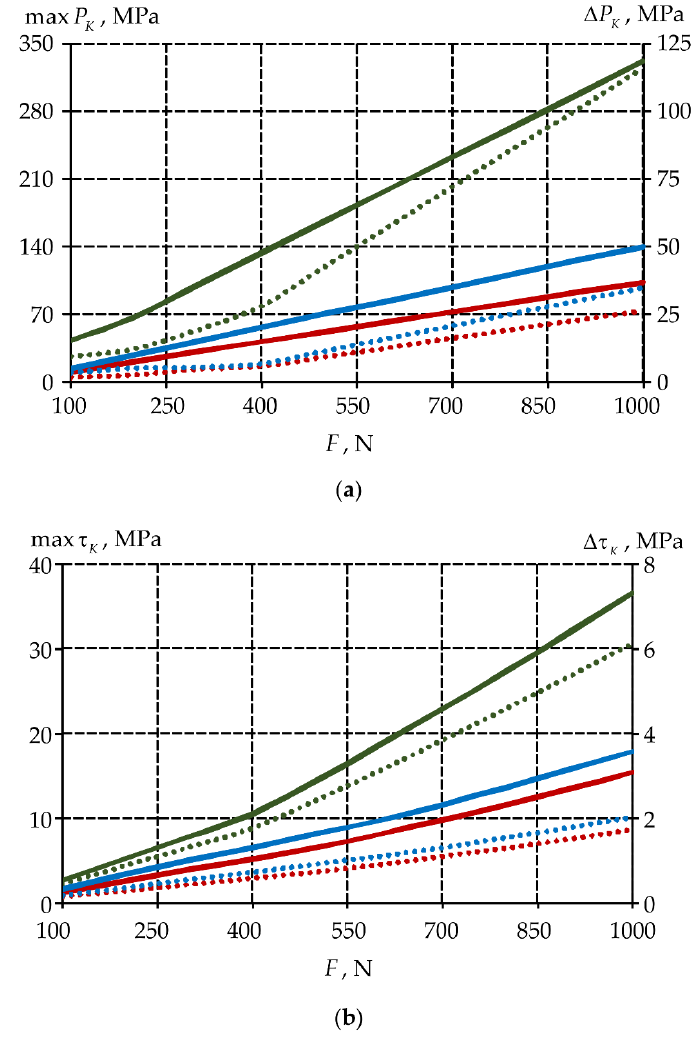
Figure 11. Dependence of contact parameters in the inlay on the load: ( a ) is contact pressure; ( b ) is tangential contact stress; solid lines is the maximum; points is the average; green is model with material 1 inlay, red is model with material 2 inlay, blue is model with material 3 inlay. The maximum contact parameters are observed near the edge of the tooth-inlay contact zone near the gingival fold, similar to stresses and strains. The average level of contact pressure and contact tangential stress is 3–4 and 7–8.9 times lower than the maximum values of the parameters respectively. The max τ K and ∆ τ K are 7–9 and 15–19 times lower than max P K and ∆ P K . The study of the influence values of the friction coefficient on the biomechanical assembly deformation is required.